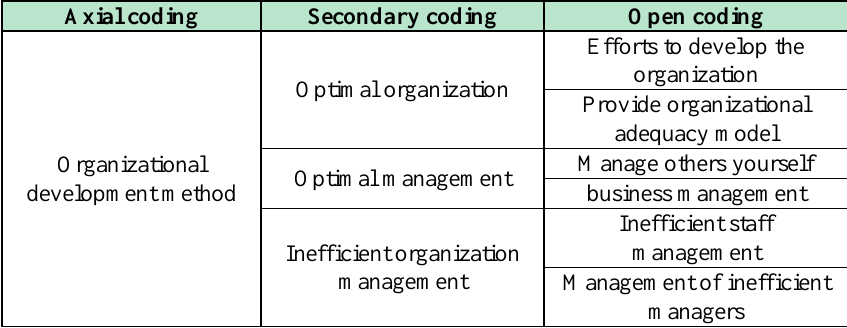
Table 2: Axial coding of qualitative data (Underlying conditions) Axial coding